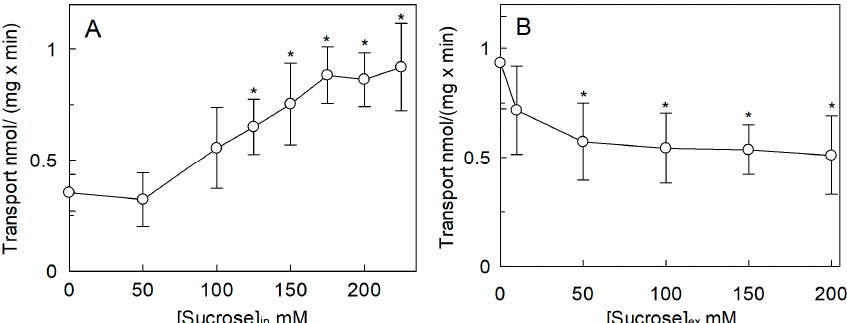
Figure 3. Effect of osmotic pressure on the transport activity of Sl CAT2 in proteoliposomes. Sl CAT2 was purified and reconstituted in proteoliposomes as described in Section 4.4. ( A ) Transport rate (nmol/(mg × min)) was measured in 10 min, as described in Section 4.5, by adding 100 µM [ 3 H]Arg to proteoliposomes containing indicated concentrations of sucrose and 15 mM ATP, at pH 7.5. ( B ) Transport rate was measured in 10 min, as described in Section 4.5, by adding 100 µM [ 3 H]Arg together with indicated concentrations of sucrose to proteoliposomes containing 200 mM sucrose and 15 mM ATP, at pH 7.5. Results are the means ± SD from three experiments. (*), Significantly different from the control (without sucrose in both ( A) and ( B )) for p < 0.05 as calculated from Student’s t -test analysis.